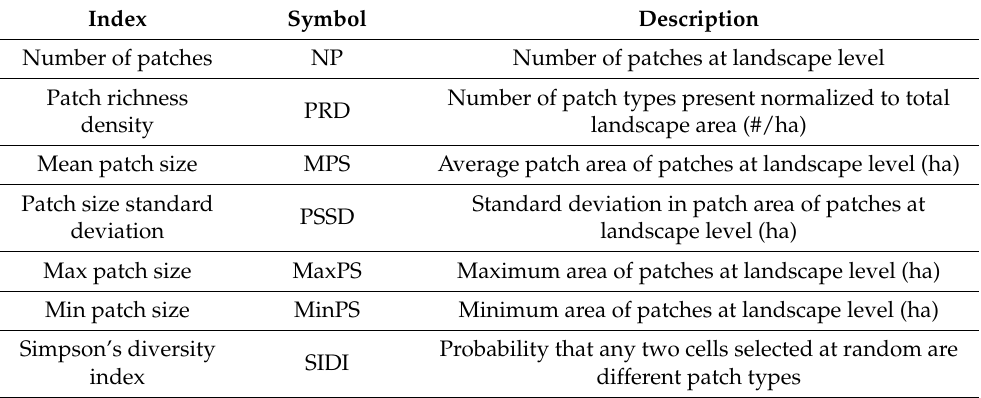
Table 2. List of the metrics selected for landscape analysis at the landscape level and their